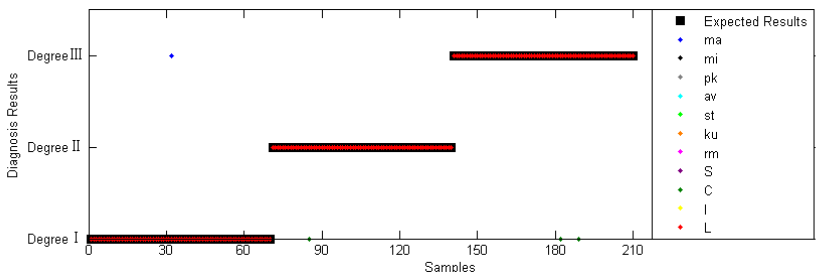
Figure 12. Diagnosis results of outer race fault severity estimation based on the BPNN_OR network.